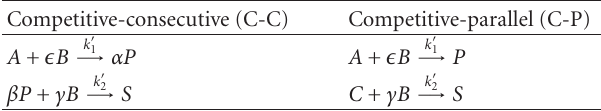
Table 2: General mixing sensitive reaction schemes. Competitive-consecutive (C-C) Competitive-parallel